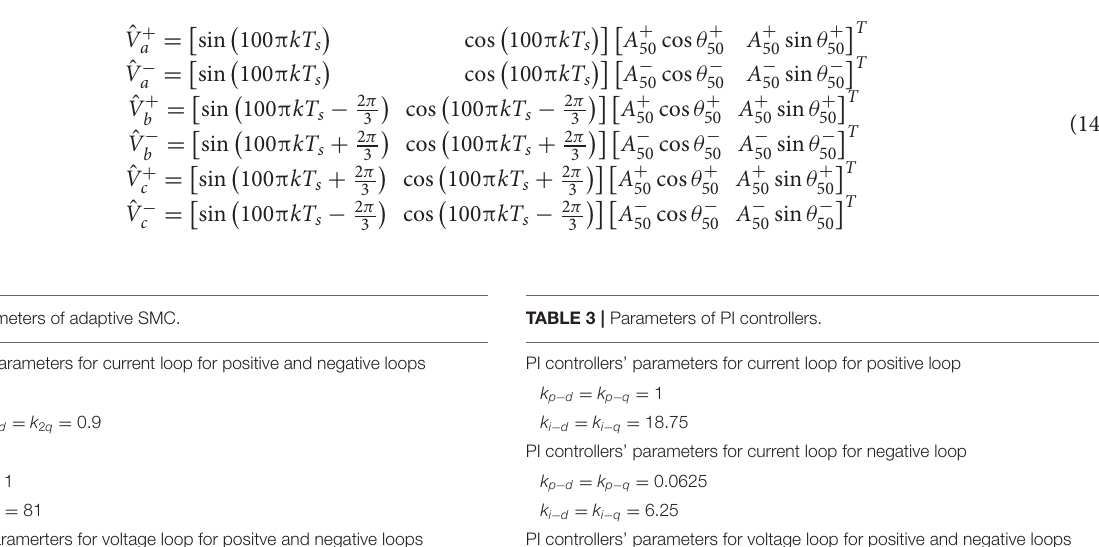
PI controllers’ paramerters for voltage loop for positve and negative loops k p − d = 0.282, k i − d = 1.333